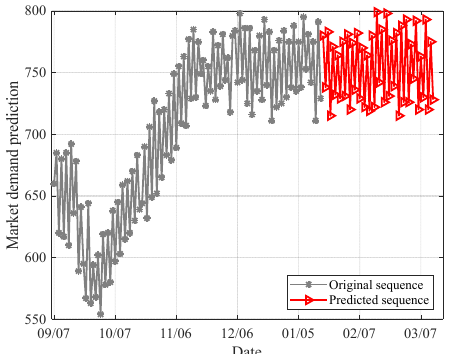
Figure 13. Future forecast performance of the proposed MHA ‐ GRU model.